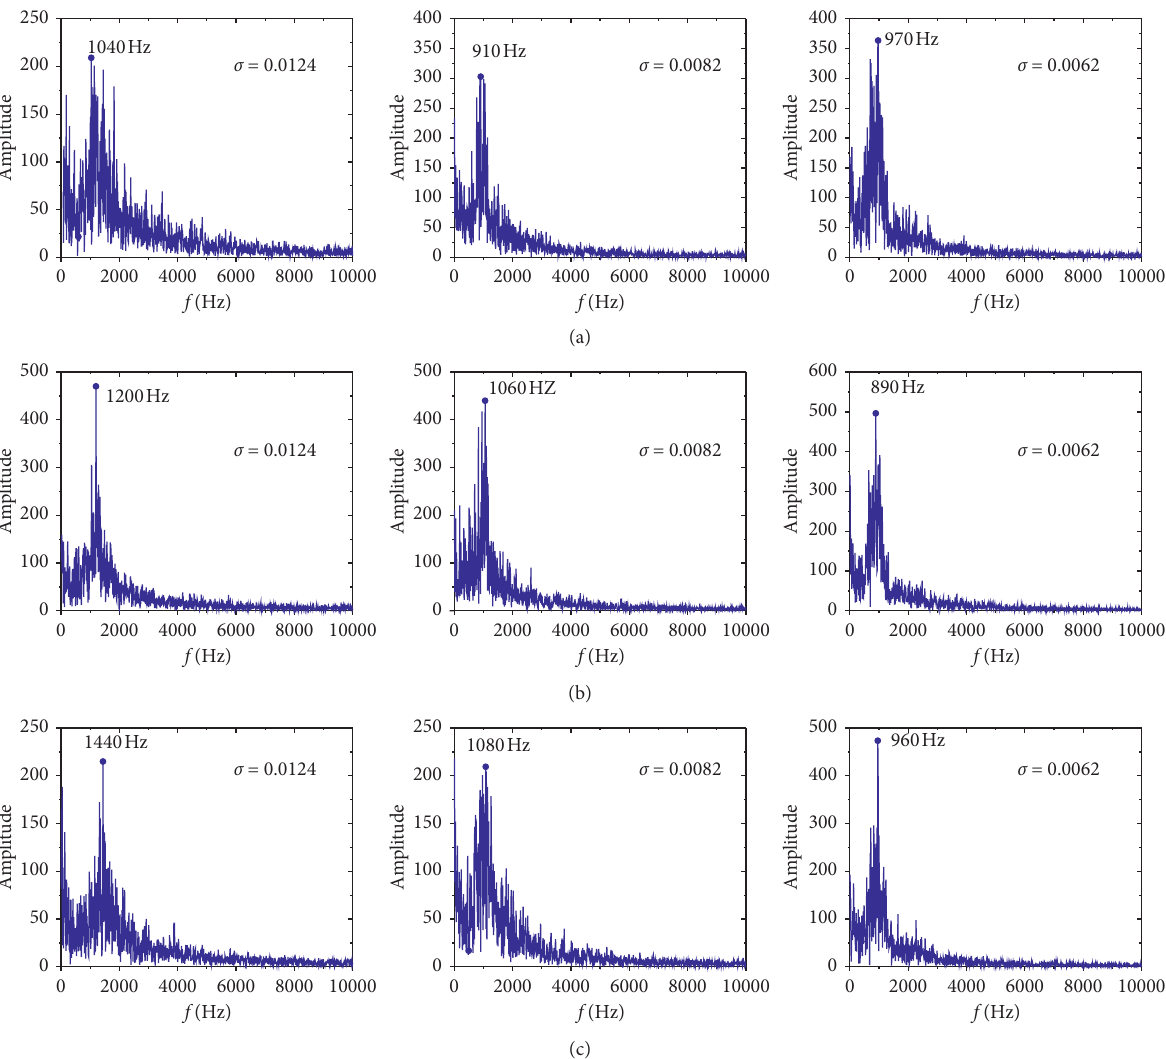
Figure 11: Frequency-domain diagram of global average grayscale with each nozzle at different pressures. (a) Nozzle with a divergent angle of 40 ° . (b) Nozzle with a divergent angle of 80 ° . (c) Nozzle with a divergent angle of 120 °